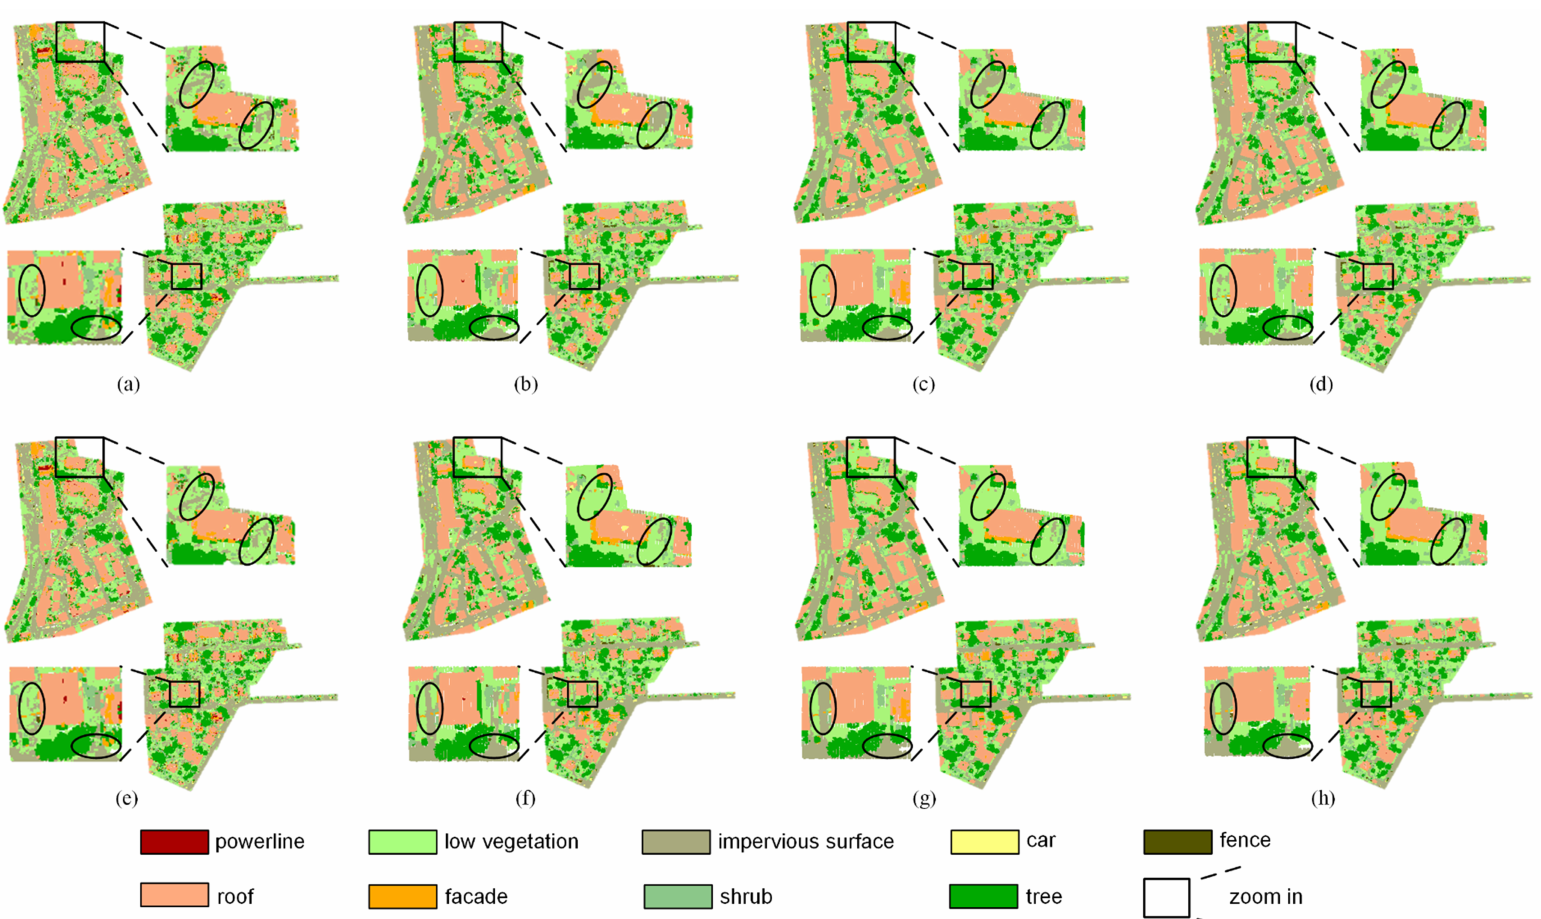
Figure 6. Classification result of testing data. Upper row is the result of supervised learning methods without intensity: ( a ) decision tree (DT), ( b ) support vector classification (SVC), ( c ) random forest (RF), ( d ) extreme gradient boost (XGBoost). Bottom row is the result of the proposed method which joint the result of supervised and unsupervised learning methods: ( e ) DT + Gaussian mixture model (GMM), ( f ) SVC + GMM, ( g ) RF + GMM, and ( h ) XGBoost + GMM.